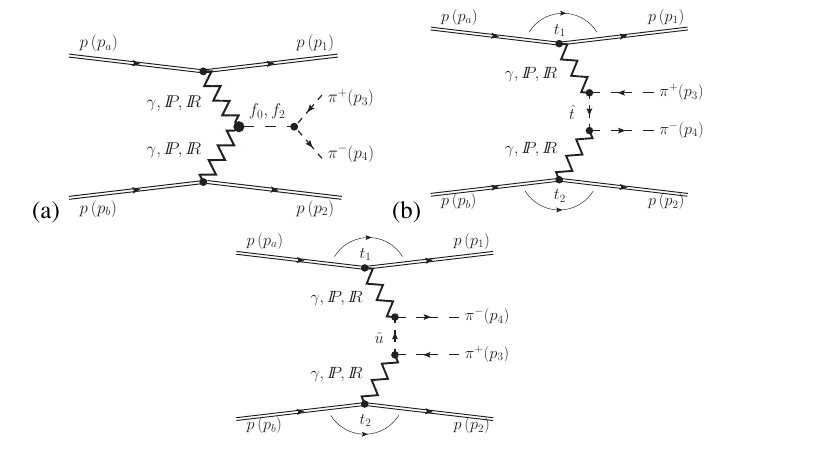
Figure 1. The diagram (a) shows the double-pomeron / reggeon and photon mediated central exclusive I G J PC = 0 + 0 ++ and 0 + 2 ++ resonances production and their subsequent decays into π + π − in proton- proton collisions. Two diagrams in panel (b) show exclusive continuum π + π −